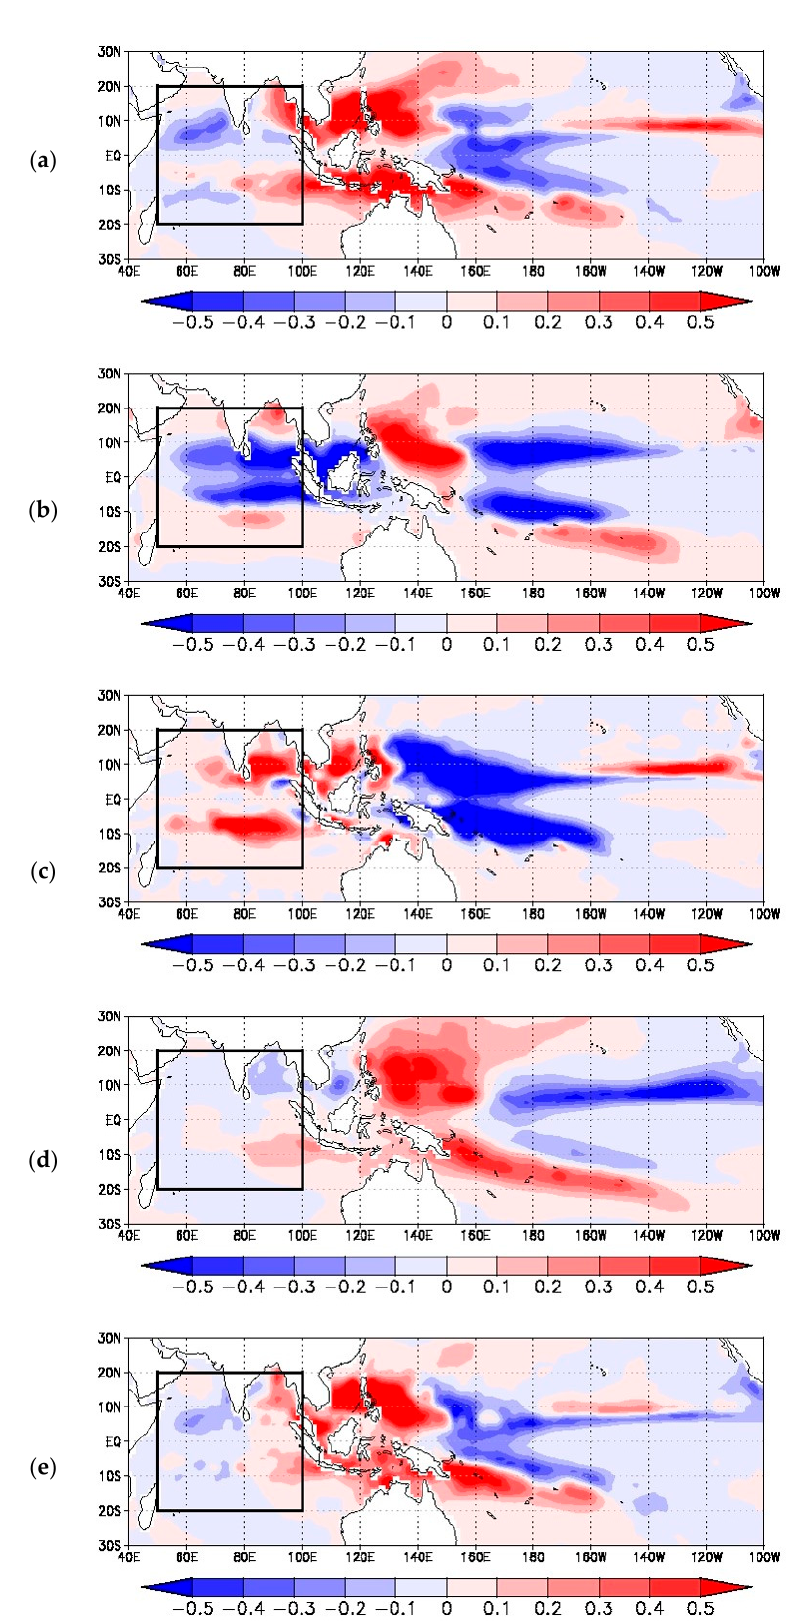
Figure 6. The same as Figure 3, except for the GPI anomalies in the La Niña years from ( a ) relative humidity; ( b ) vertical shear; ( c ) vorticity; ( d ) MPI; and ( e ) vertical velocity.